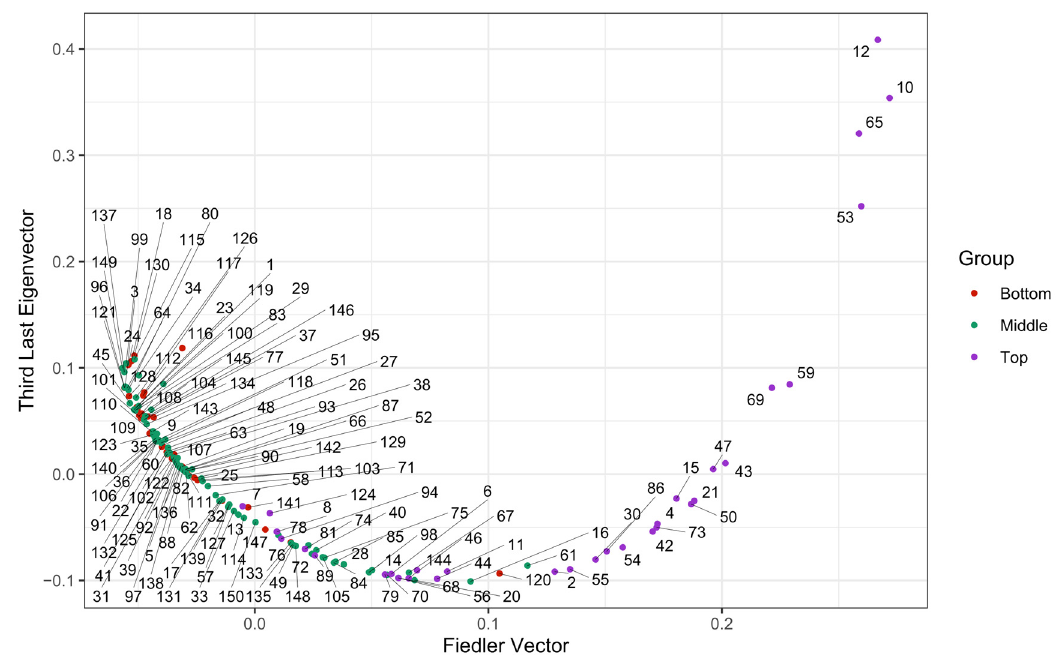
Figure 3. 3D scatter plot of Laplacian eigenmap using the three smallest positive eigenvectors ( a – d ) offer different angles of the 3D structure.